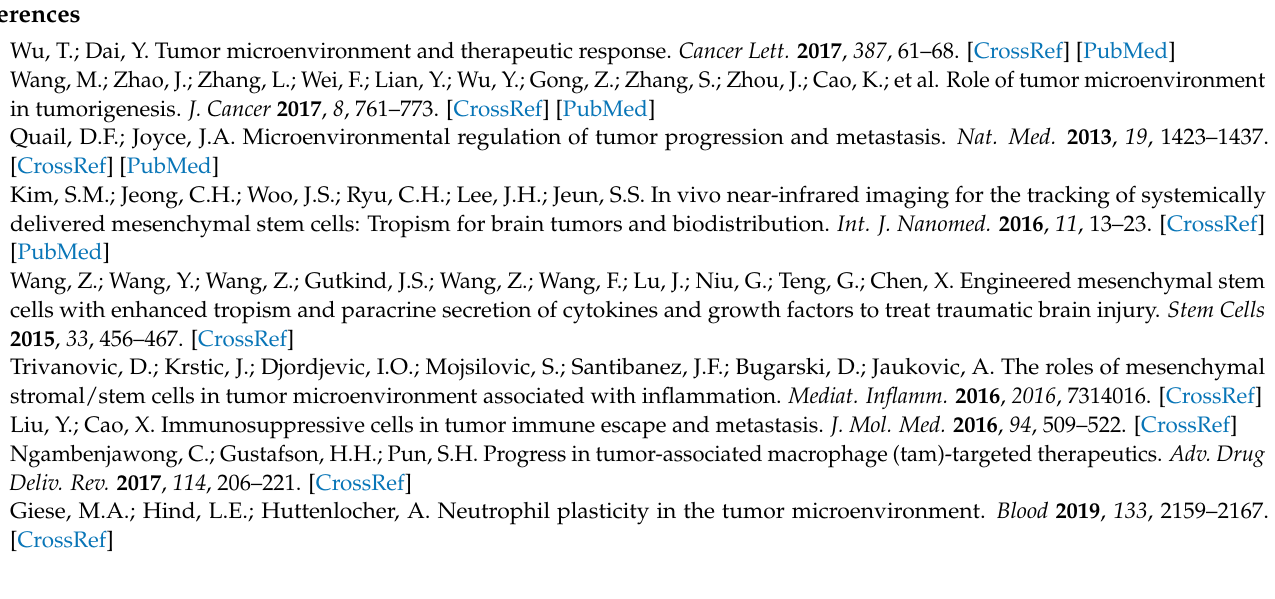
Figure A1. Flow cytometric analysis of SH-SY5Y cells and BM-MSCs colored with vital dye. SH-SY5Y cells colored with DiO dye ( A , C ), BM-MSCs (monoculture) colored with the vital DiD dye after cultivation for 96 h. ( A , B ) Plastic, ( C , D ) Matrigel. Q1—population of cells with green fluorescence (DiO). Q2—population of cells with mixed fluorescence (DiO + DiD). Q3—unstained population. Q4—population of cells with red fluorescence (DiD).